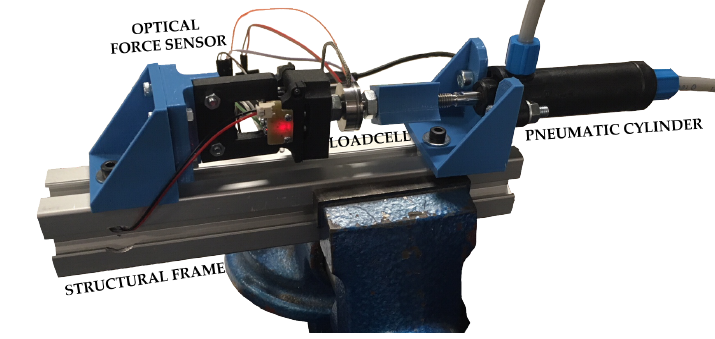
Figure 9. Test bench for validation